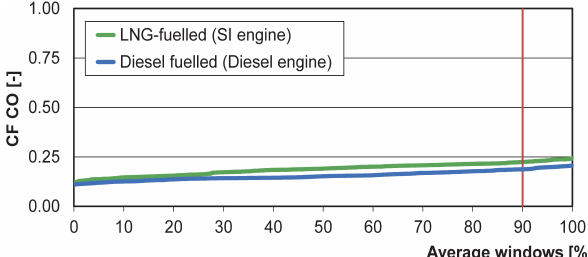
Figure 9: Conformity factor for specific non-methane hydrocarbons emissions for the two tested buses.